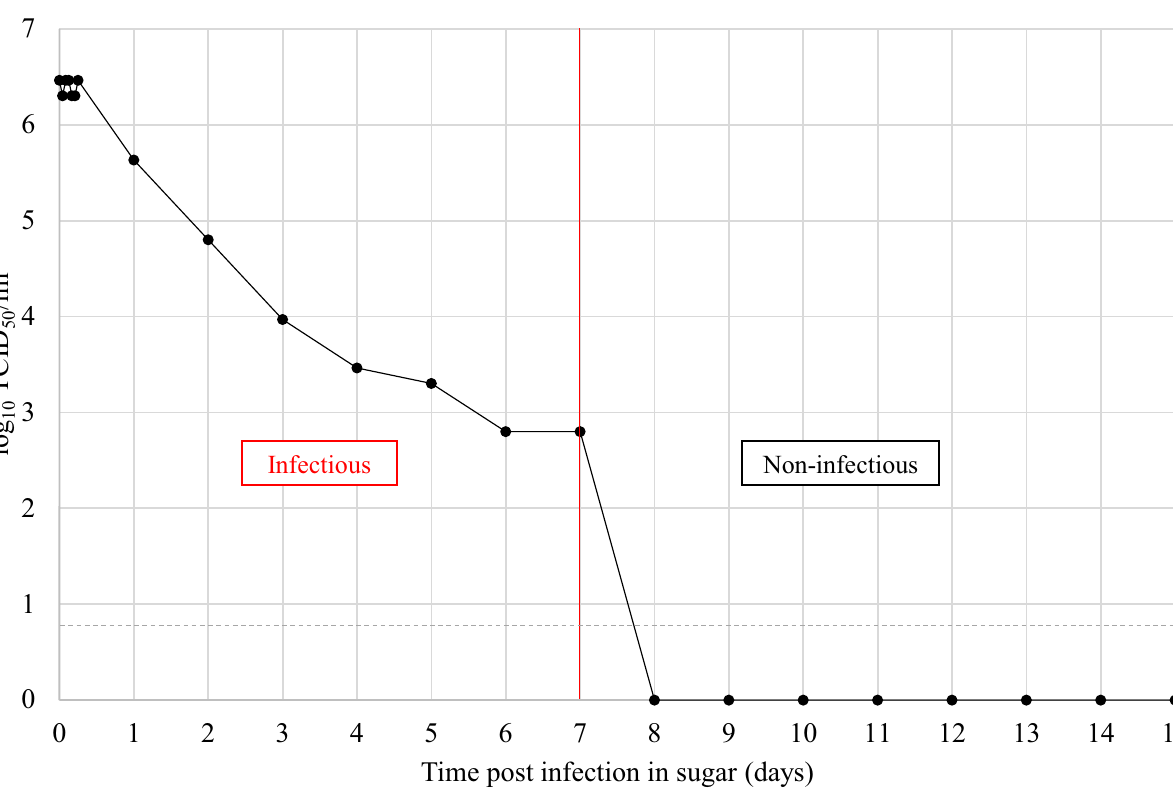
Figure 3. Toscana virus infectivity (TCID 50 /ml) in the sugar solution over time post infection. The red vertical line represents the boundary between infectious and non-infectious samples. The grey dashed horizontal line corresponds to the limit of detection of infectivity (0.8 log 10 TCID 50